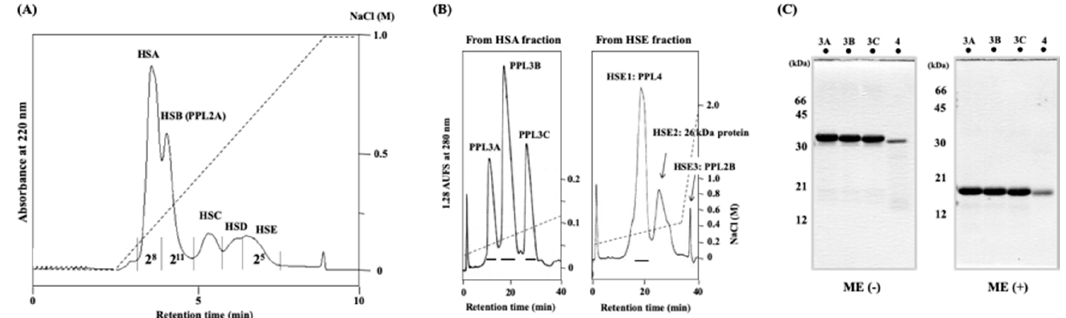
Figure 1. Purification of PPL3s and PPL4. Cation-exchange chromatography of the secreted fluid of Pteria penguin mantle on POROS HS column ( A ) and on Resource S column (ø 6.4 × 30 mm) ( B ). Flow rate was 1 mL / min. Lectin activity of each peak fraction in ( A ) was indicated by hemagglutination activity that defined as a titer value of maximum dilution with positive agglutination of 2% rabbit erythrocytes. SDS-PAGE (15%) profiles of PPL3s (3A, 3B, 3C) and PPL4 under non-reducing (ME(–)) and reducing (ME(+)) conditions after purification ( C ).